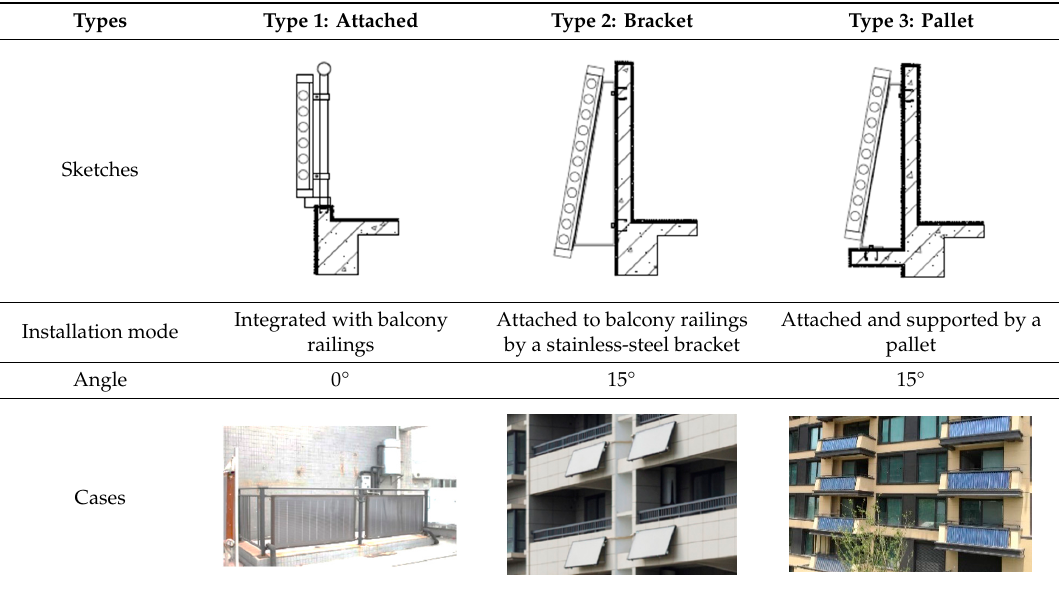
Table 6. Solar collector installation modes on balconies.